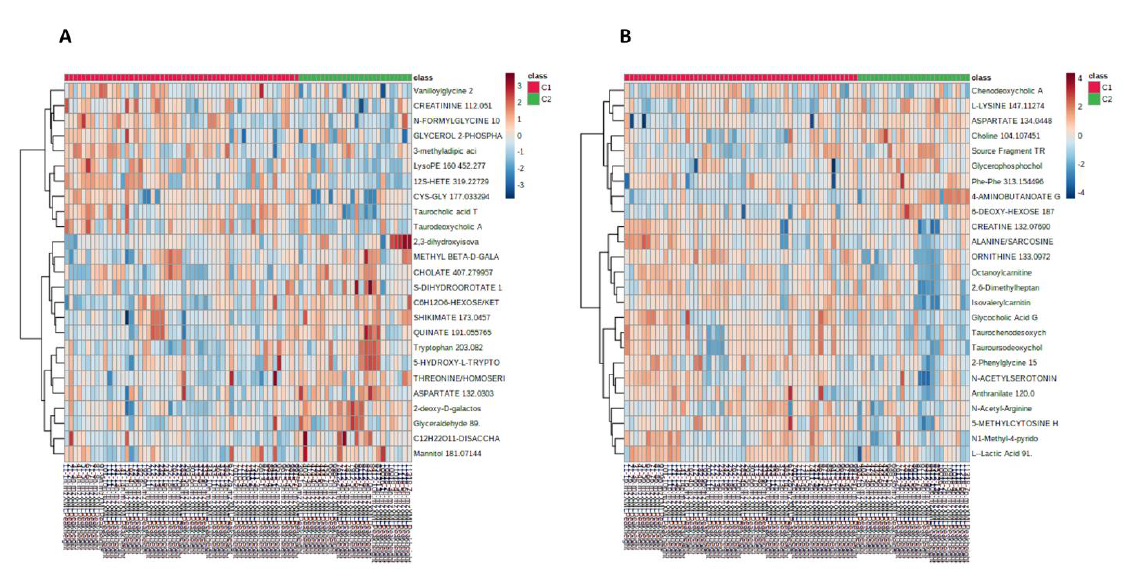
Figure 3. Heat map. Color gradients depicting increased (red) versus decreased (blue) concentrations. ( A ) Top 25 negative ion metabolites ( p < 0.05). ( B ) Top 25 positive ion metabolites ( p < 0.05).